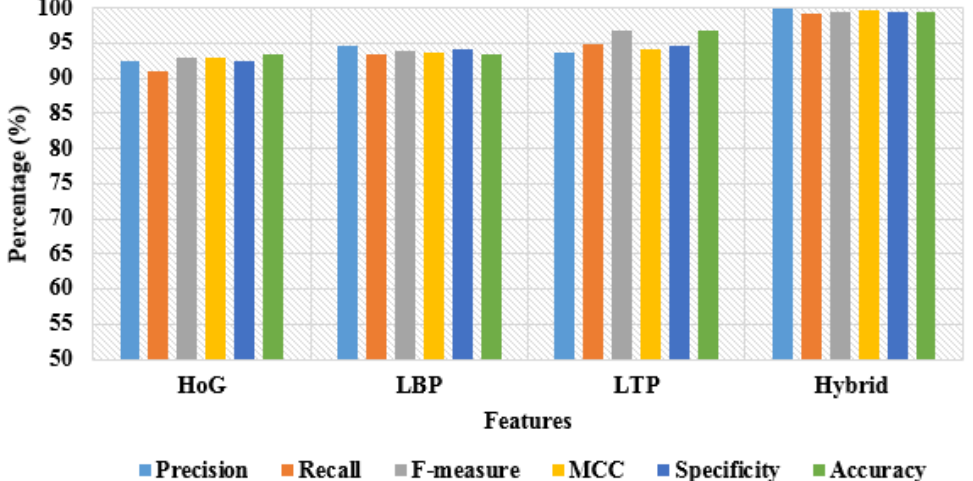
Figure 12. Graphical comparison of dissimilar features with 80% training and 20% testing of data.